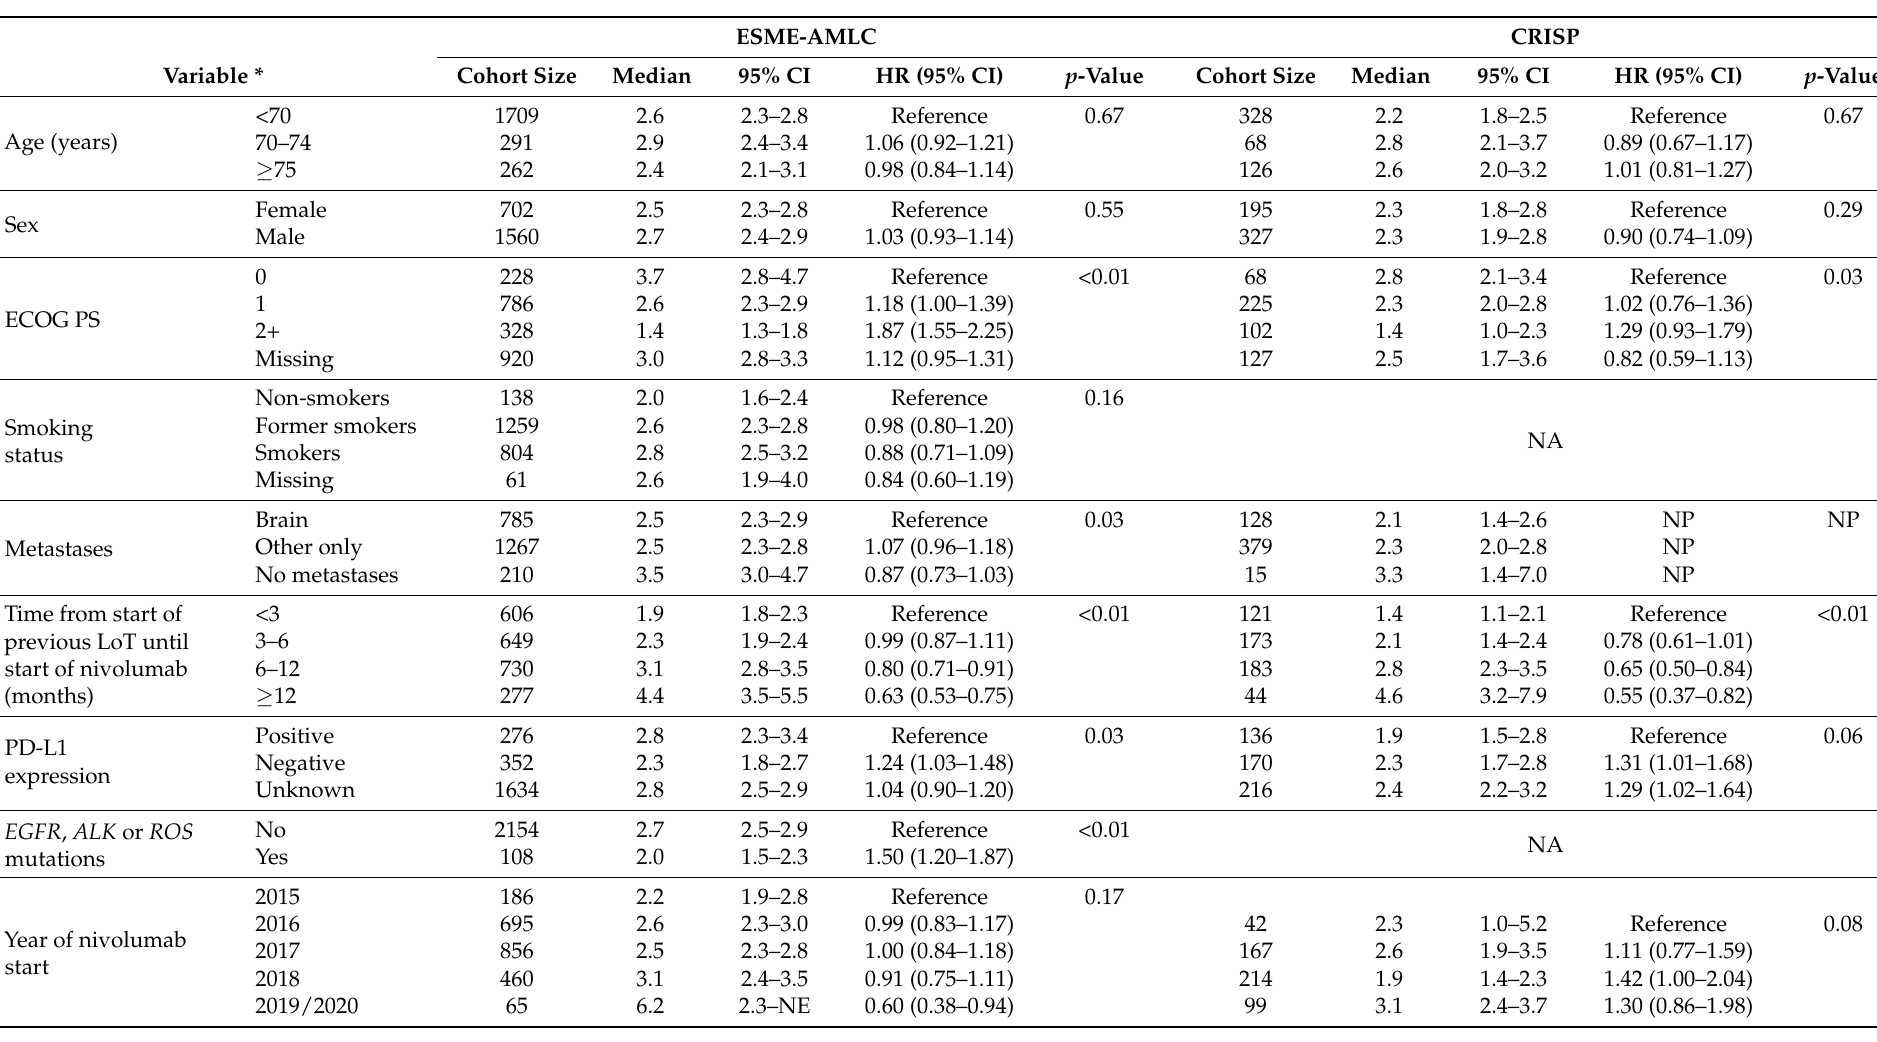
Table 4. Factors associated with treatment duration in patients treated with nivolumab in ESME-AMLC and CRISP (multivariate Cox model; table and forest plot). ESME-AMLC